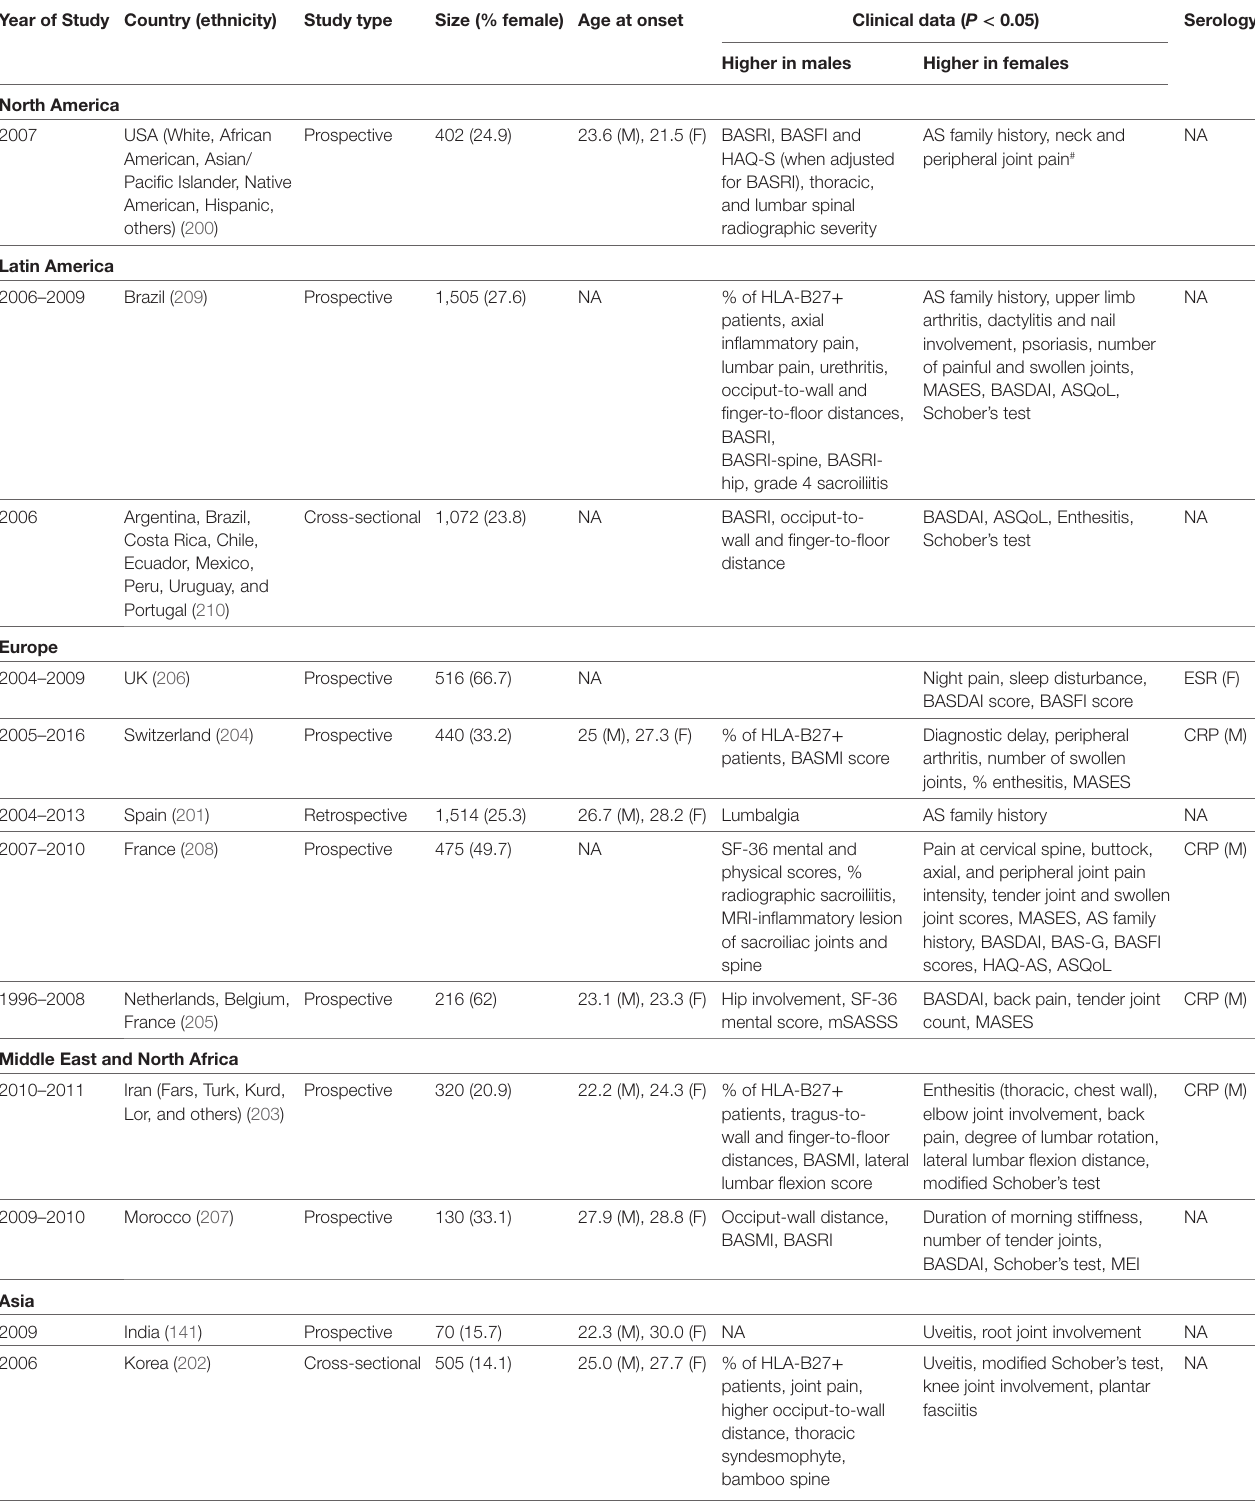
F, female; M, male; NA, not applicable; ESR, erythrocyte sedimentation rate; CRP, C-reactive protein; BASDAI, Bath Ankylosing Spondylitis Disease Activity Index; BAS-G, Bath Ankylosing Spondylitis Patient Global disease activity score; BASRI, The Bath Ankylosing Spondylitis Radiology Index; BASFI, Bath Ankylosing Spondylitis Functional Index; BASMI, Bath Ankylosing Spondylitis Metrology Index; MASES, Maastricht Ankylosing Spondylitis Enthesitis Score; mSASSS = modified Stoke Ankylosing Spondylitis (AS) Spine Score; SF-36 = Medical Outcomes Study 36-item Short Form; ASQoL = Ankylosing Spondylitis Quality of Life Questionnaire; HAQ-AS = Health Assessment Questionnaire for the Spondyloarthropathies; MEI = Mander enthesis